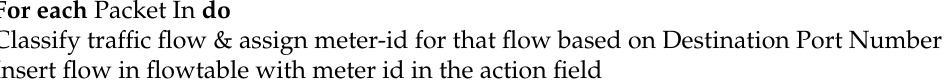
Algorithm 2 Adaptive Quality of Service Algorithm: Operation Phase